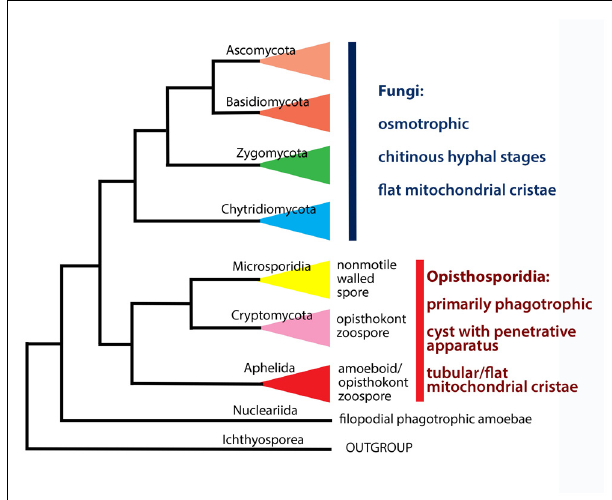
FIGURE 5 | Phylogenetic and taxonomic summary of early diverged groups of